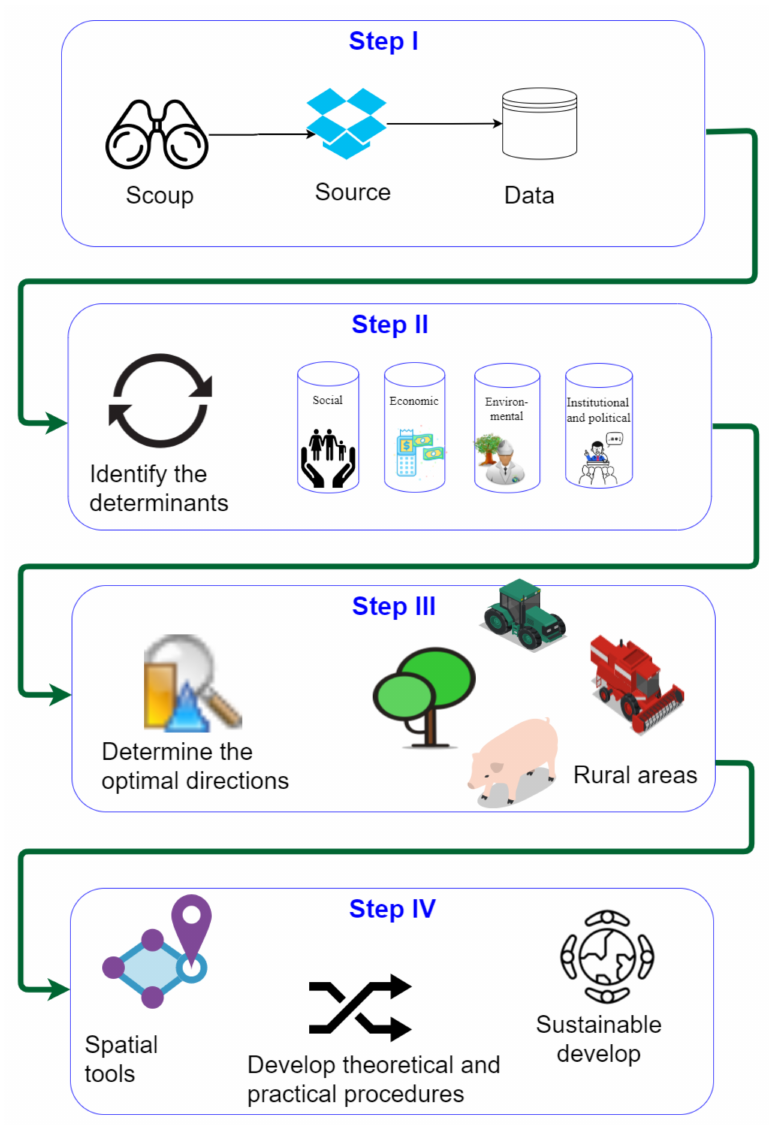
Figure 2. The procedure of using spatial data and spatial analyses in the sustainable development of rural areas. Source: own